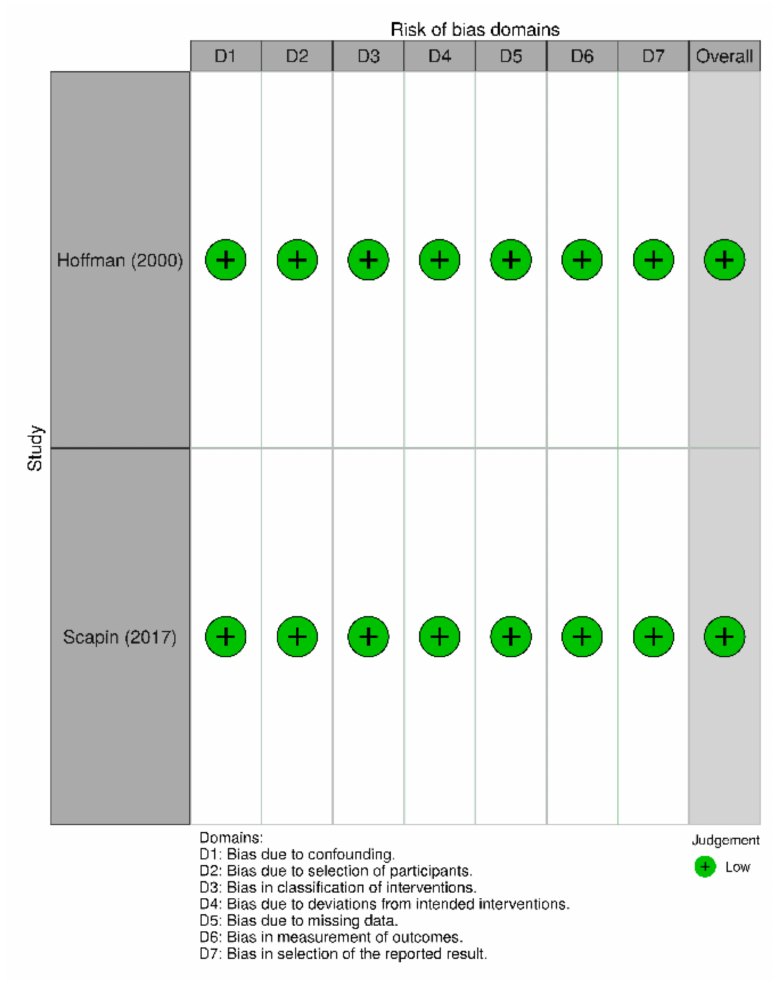
Figure A4. Risk of bias tra ffi c light plot: review authors’ judgements about each risk of bias item presented as percentages across all included non-randomized